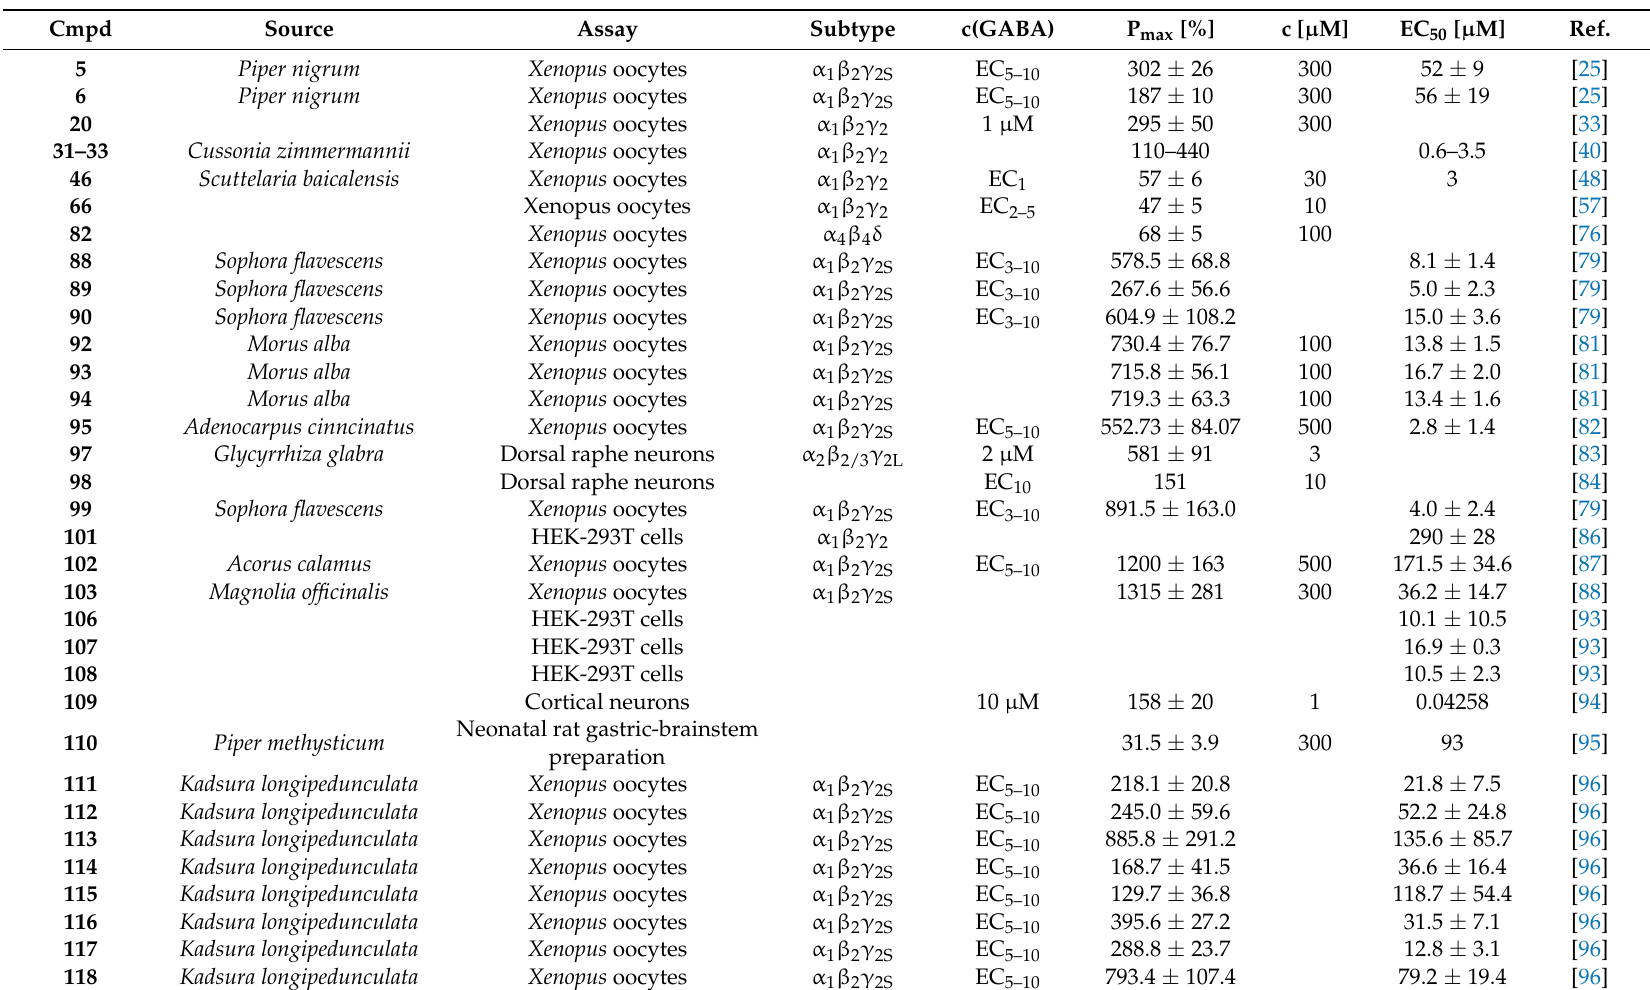
Table 2. Data from electrophysiological studies of GABA(A) receptor